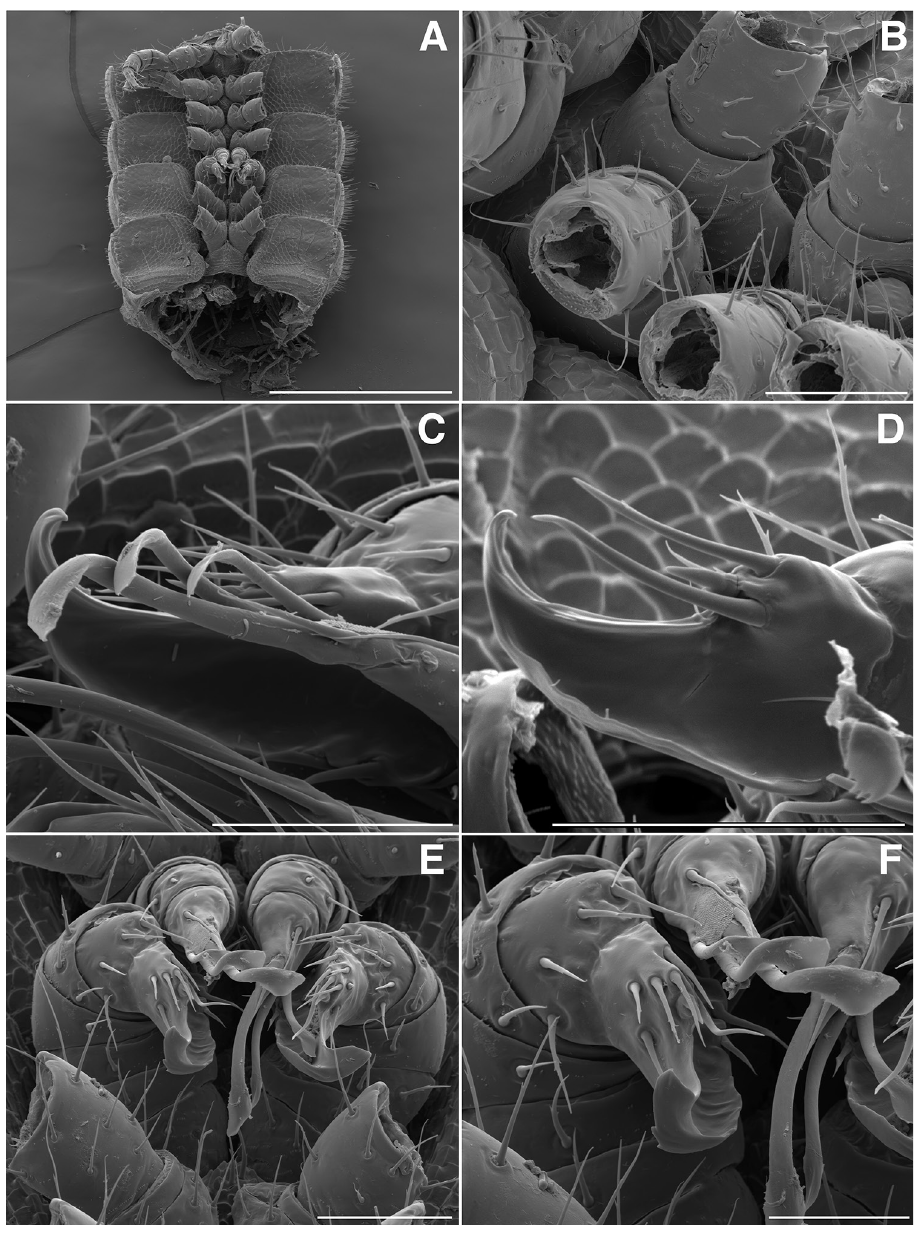
Figure 18. A Anteroventral view of rings 6–9 of I. tobini sp. n. with gonopods in situ (scale bar 400 µm) B ventrolateral (right) view of second leg pair with posteriorly oriented coxal gonapophyses (legs broken off at prefemur-femur joint) (scale bar 50 µm). C Medial view of right anterior gonopod of I. tobini sp. n. (scale bar 40 µm) D the same of I. plenipes (scale bar 50 µm). Illacme tobini sp. n.: E anteroventral view of gonopods in situ (scale bar 50 µm) F the same, close-up of right anterior gonopod (scale bar 30 µm). (Catalog #s: I. tobini sp. n. MPE00735, I. plenipes